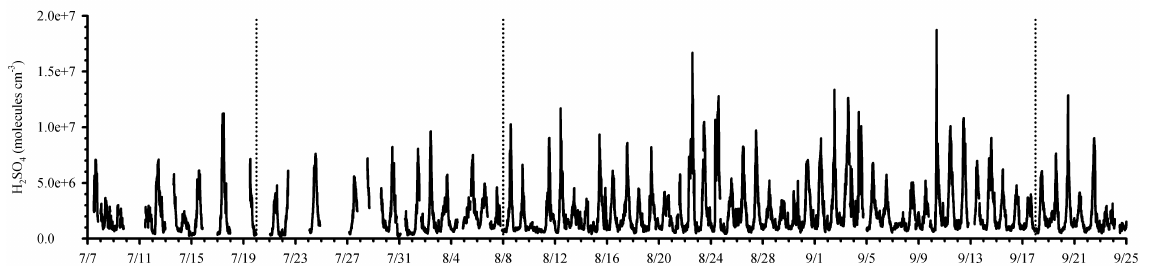
Fig. 3. Time series of 10 min averaged GSA concentration observed from 7 July to 25 September during the CAREBeijing 2008 Campaign. The dotted lines indicate the date of implementation of some major emission control measures, i.e. 20 July when odd/even plate number rule was applied, 8 August when full-scale control was applied, and 18 September when the regulations were loosened.